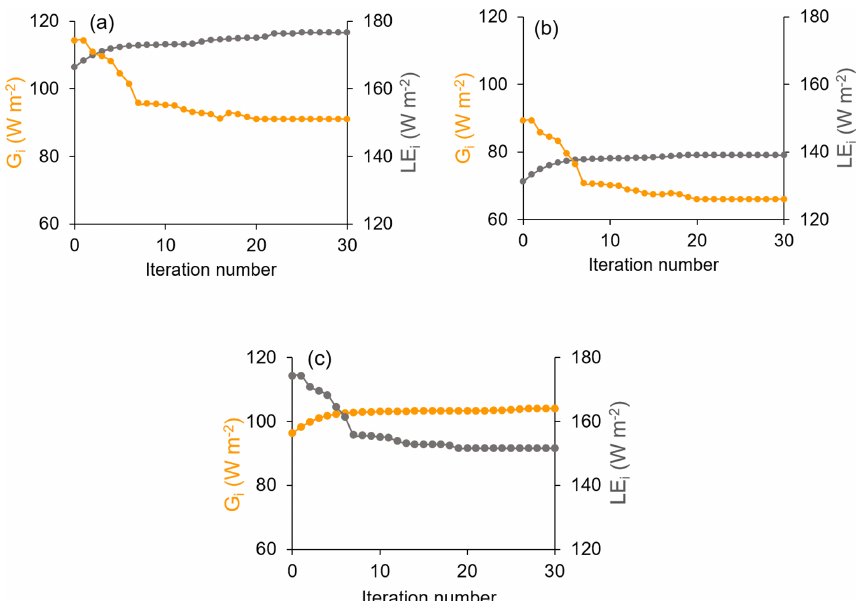
Figure 4. Illustrative examples of iterative stabilization of STIC-TI G i (yellow marker line) and LE i (grey marker line) in (a) IND-Jai, (b) AU-ASM, and (c)